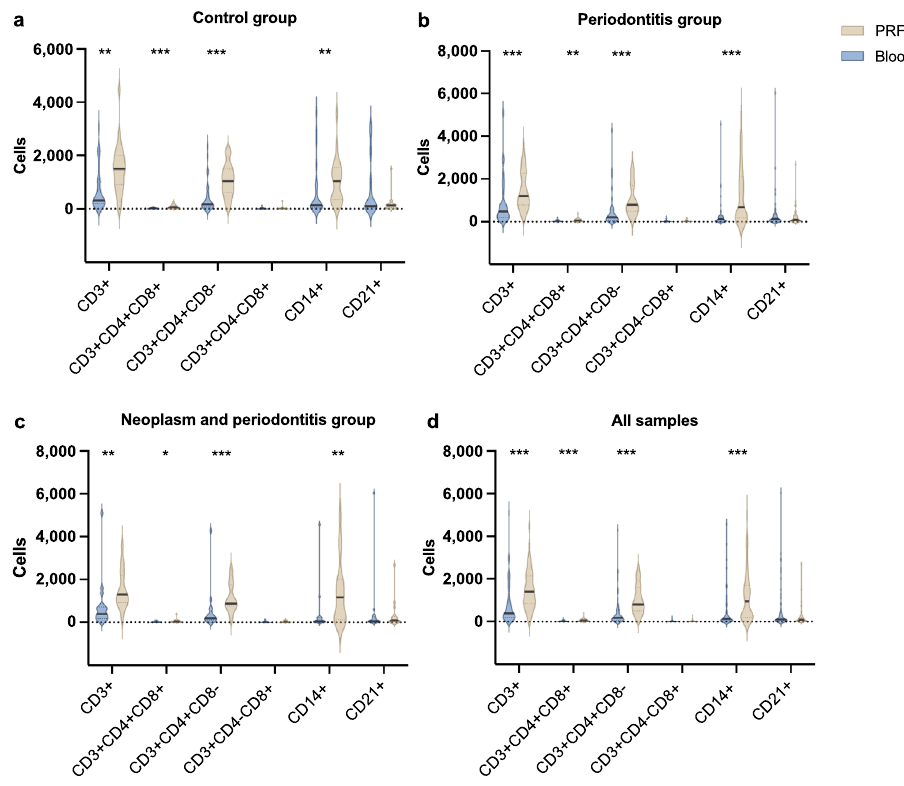
Figure 2. Comparison of PBMC groups between whole blood (blue) and PRF samples (brown) in three patient groups: ( a ) control, ( b ) periodontitis, and ( c ) neoplasm and periodontitis. PBMC distribution of all samples is presented in ( d ). * p < 0.05, ** p < 0.01, *** p <